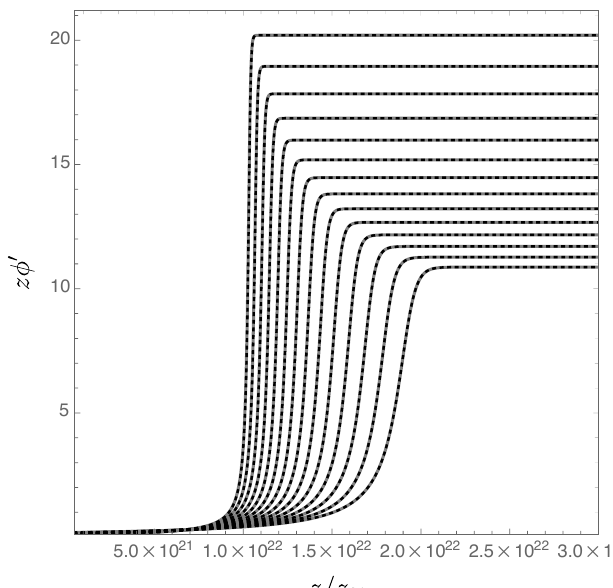
≈ 0.070 − 0.130, with T / T ≈ 0.983. o c